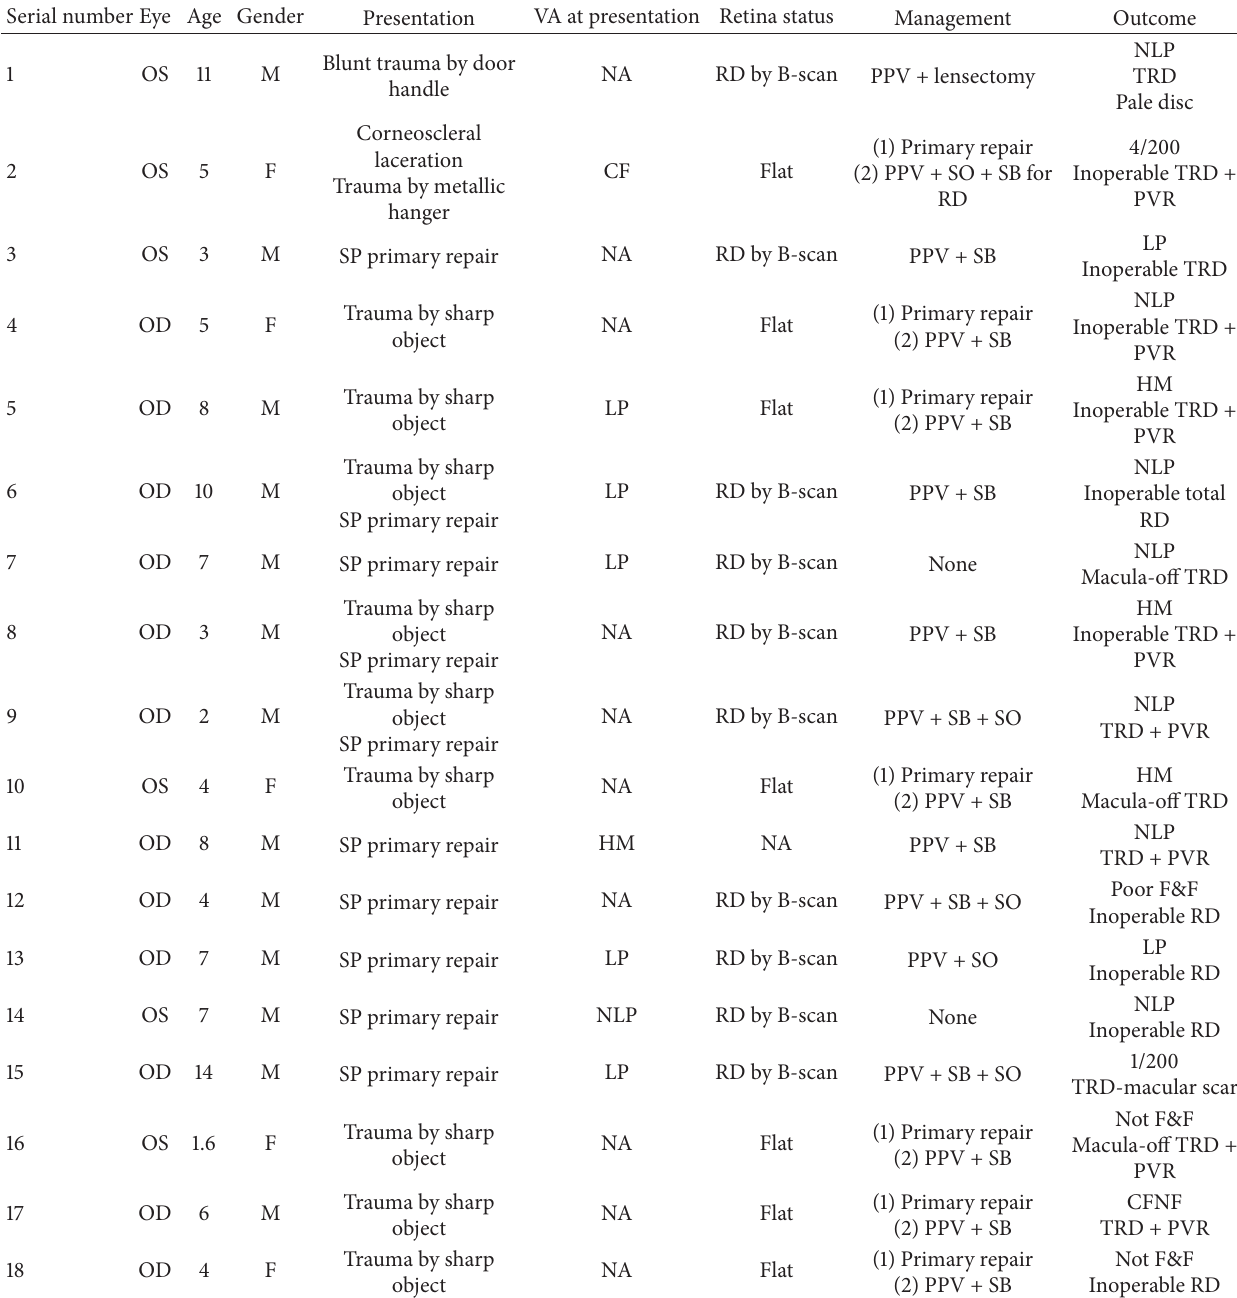
Table 9: A summary of the 18 eyes with vitreous hemorrhage caused by accidental trauma and that had retinal detachment at last follow-up. Serial number Eye Age